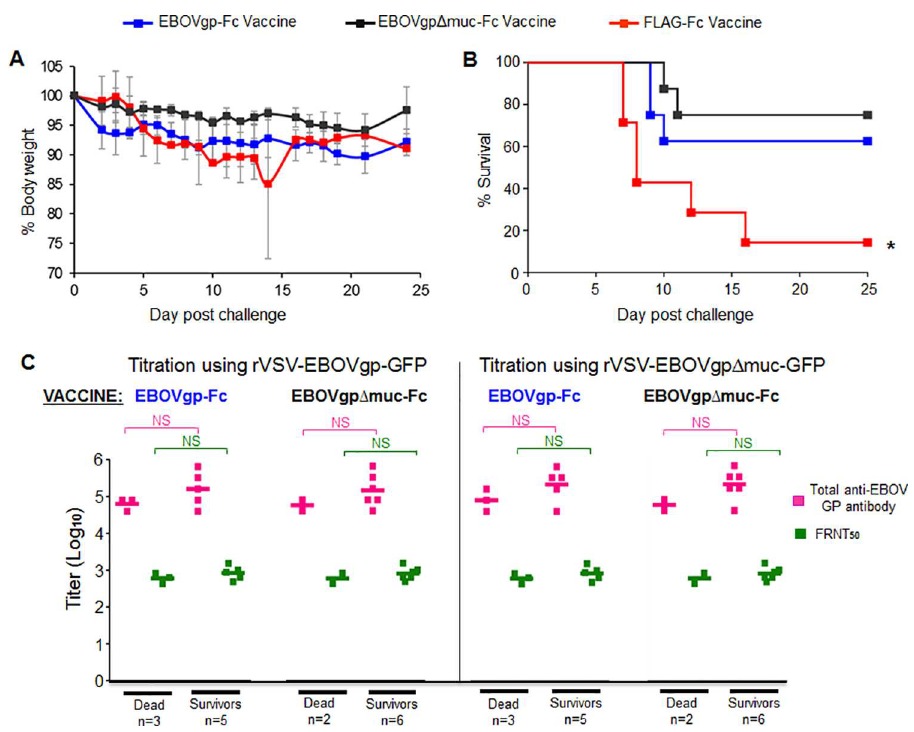
Fig 3. EBOV lethalchallengeof strain13 guineapigs immunized withQS-21adjuvanted EBOVgp-Fc or EBOVgp Δ muc-Fc vaccines. Groups of guineapigs vaccinated with QS-21adjuvanted EBOVgp-Fc (n = 8, blue squares), EBOVgp Δ muc-Fc (n = 8, gray squares),or FLAG-Fc (n = 7, red squares)were challengedwith 1,000 pfu of EBOV/May-GPA two weeks afterthe thirdboost. (A) Weight loss afterchallenge with EBOV/May-GPA. Guineapigs were weighed daily for 24 days. Data are group averages and bars indicatethe standarderrorsof the mean.(B) Kaplan-Meiersurvivalcurves are plottedas percentsurvivalfor each vaccination group. Significant differences ( * , P < 0.05)between vaccinated (EBOVgp-Fc) and control (FLAG-Fc) animalsas determined by the Mantel-Cox test.(C) Anti-GPtotaland neutralizingantibodytitersof guineapigs immunizedwith the EBOVgp-Fc or EBOVgp Δ muc-Fc vaccines and challengedwith EBOV/May- GPA groupedaccordingto the outcomein animalsthat died (Dead)or survived(Survivors) the challenge. Antibodytiterswere obtainedusing rVSV-EBOVgp-GFP (leftpanel)or rVSV-EBOVgp Δ muc-GFP (right panel)recombinant VSV constructs.The mean for each group is shown as a line, totalanti-GPantibodytiters (magentasquares),FRNT50neutralizingantibodytiters(green squares),and numberof animals(n) per group. Significance in antibodytiterswere determinedby unpaired t-testbetween groups; NS, not significant.